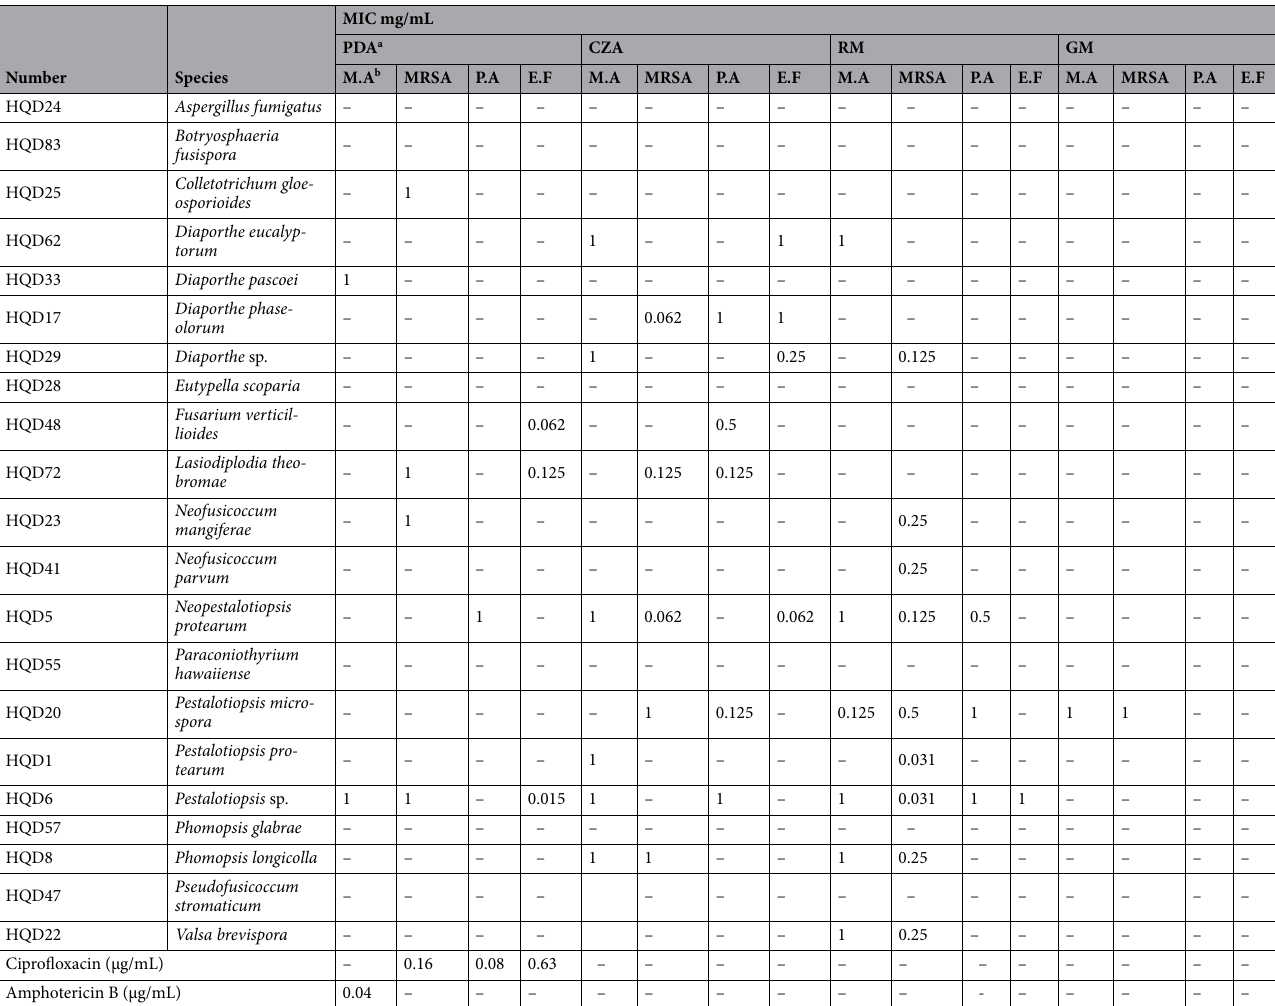
Table 2. Antimicrobial acticity of the endophytic fungi from R. mucronata. a Strains were cultivated on